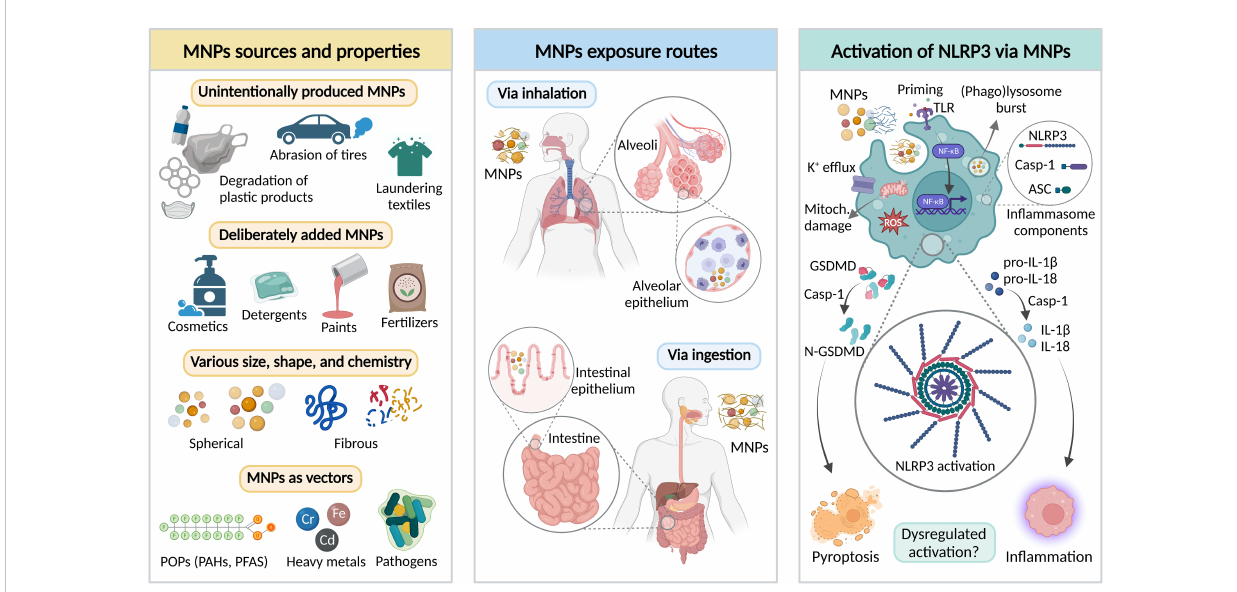
FIGURE 1 Interplay between micro- and nanoplastics (MNPs) and NLRP3 in fl ammasome canonical activation pathway. Left panel – major sources and properties of MNPs. MNPs may be unintentionally released or deliberately added to different products. MNPs signi fi cantly vary in terms of physicochemical properties, including size, shape, and chemical composition. Importantly, MNPs may act as a vector of various environmental contaminants, such as persistent organic pollutants (POPs), heavy metals, or pathogenic bacteria. PAHs – polycyclic aromatic hydrocarbons; PFAS – Per- and poly fl uoroalkyl substances. Middle panel – the main MNP exposure routes in humans include inhalation and ingestion leading to MNP interaction with alveolar and intestinal epithelia. Right panel – Putative mechanisms of MNP-mediated activation of NLRP3 in fl ammasome in the immunocompetent cells, including Toll-like receptor (TLR)-priming via NF- k B resulting in production of NLRP3 in fl ammasome components, and NLRP3 in fl ammasome activation leading to the recruitment of the caspase-1 that cleaves its effector substrates, pro-Interleukin-1 b (pro-IL-1 b ), pro- IL-18, and gasdermin-D (GSDMD). The main outcomes of the NLRP3 in fl ammasome activation include maturation and release of IL-1 b and IL-18, and pro-in fl ammatory cell death (pyroptosis). Figure was created by AA using